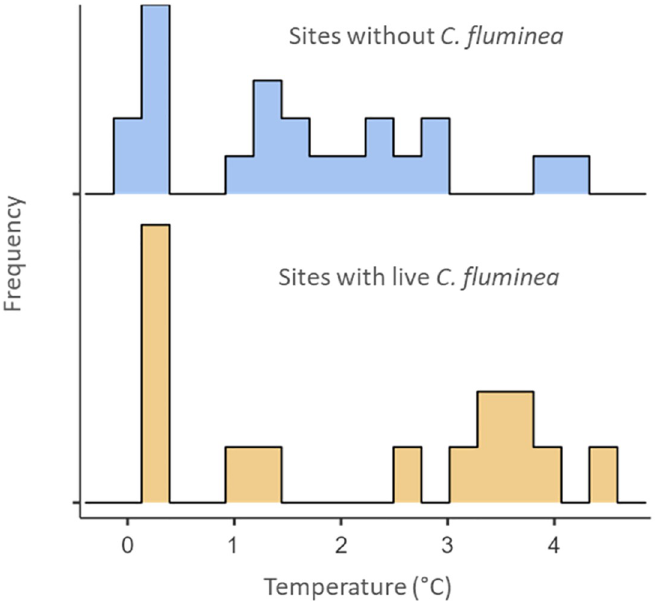
Fig 4. Winter temperature histogram. Histogram showing the frequency of individual monthly sample site temperatures (n = 37) during winter sampling activities at sites with (bottom, n = 15) and without (top, n = 22) live C.